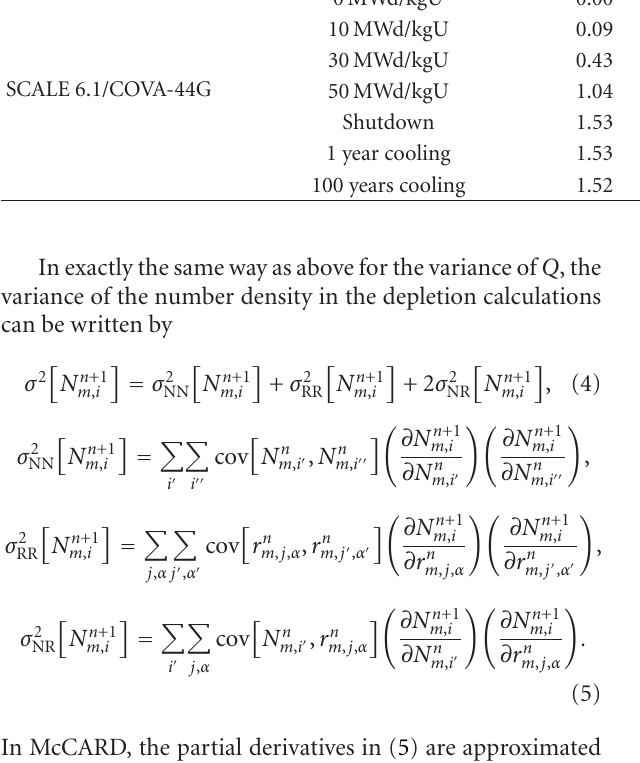
Table 4: RSDs (%) of number densities with ENDF/B-VII.1 and SCALE6.1/COVA covariance data . Cov. data